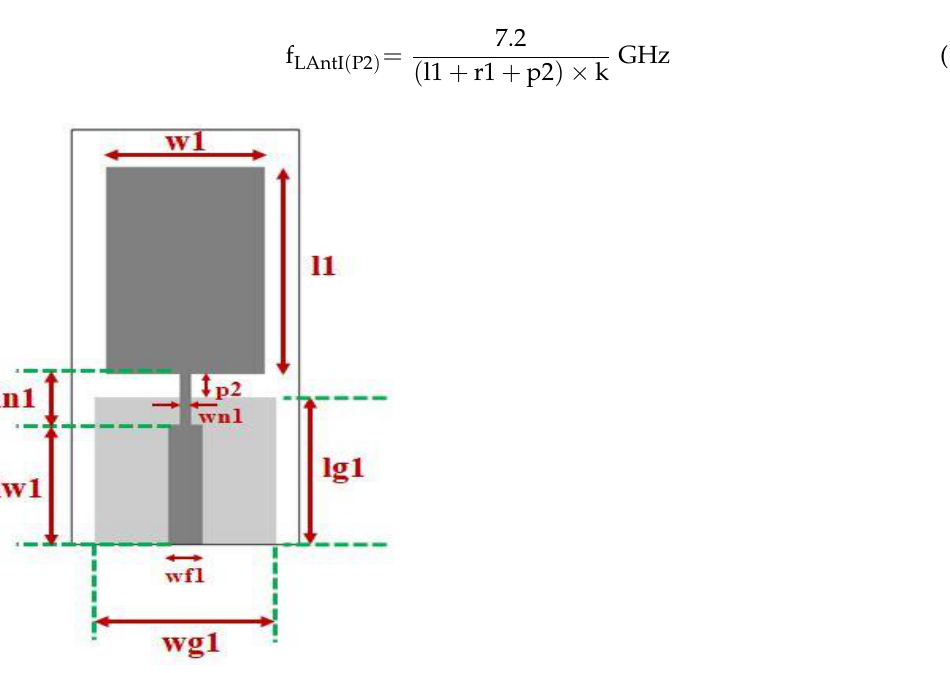
Figure 5. Schematic of the antennas linked with P2 to P9. In Equation (1), l1 and p2 are the length of the rectangular patch and feed gap in centimeters, respectively. The term ‘r1 (cid:48) in centimeters can be calculated from the width of rectangular patch since r1 = w 1 . The term ‘k’ is constant and is equal to 1.15. 2 π After finding out the values of l1, r1, p2 and k, the LBE frequency of Ant I in Figure 1 is found as 2.3 GHz, whereas it is found as 2.34 GHz in simulation. It is evident from Figure 7 that Ant I operates at 2.34- 2.9 GHz and 4.9–7.75 GHz. As the antenna linked